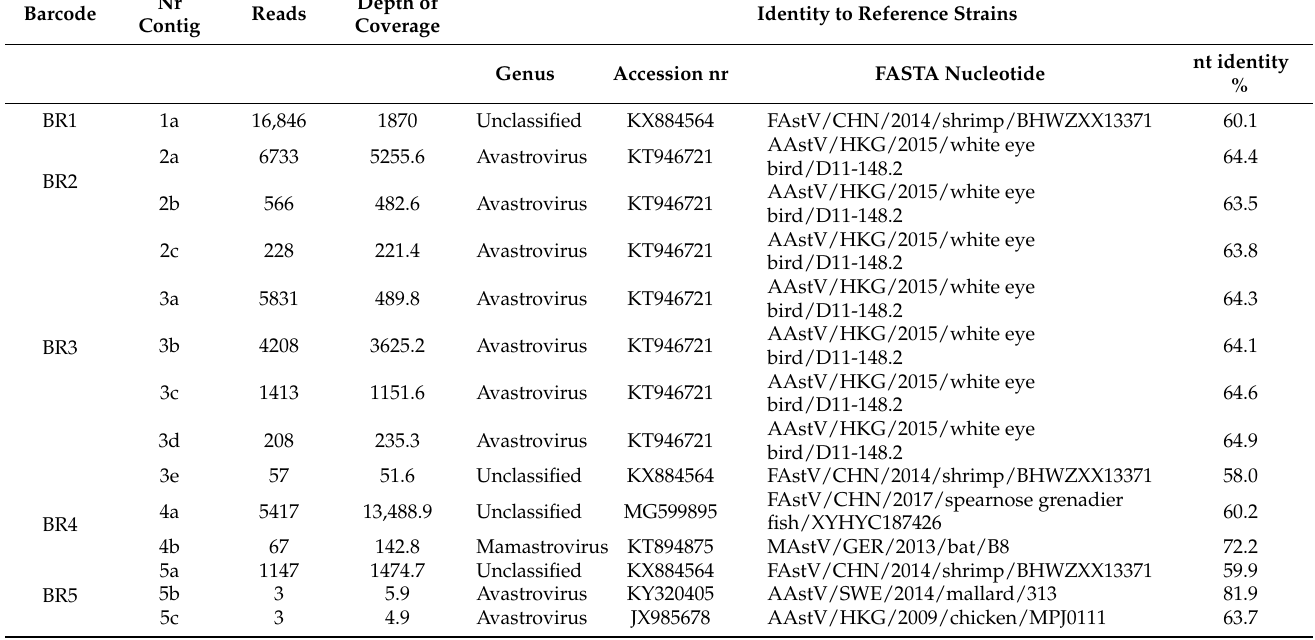
Table 1. Results of sequence analysis on the contigs generated with the astroviromic protocol. The number of reads per contig, the depth of coverage for each contig and the best match upon FASTA interrogation of the Ensemble database of the European Bioinformatics Institute (accessed on 31 st December 2022) are shown. Classification at the genus level is based on NCBI taxonomical assignment.